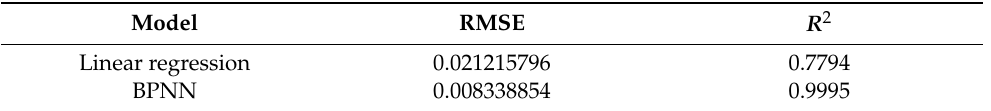
Table 13. BPNN parameter experiment results.